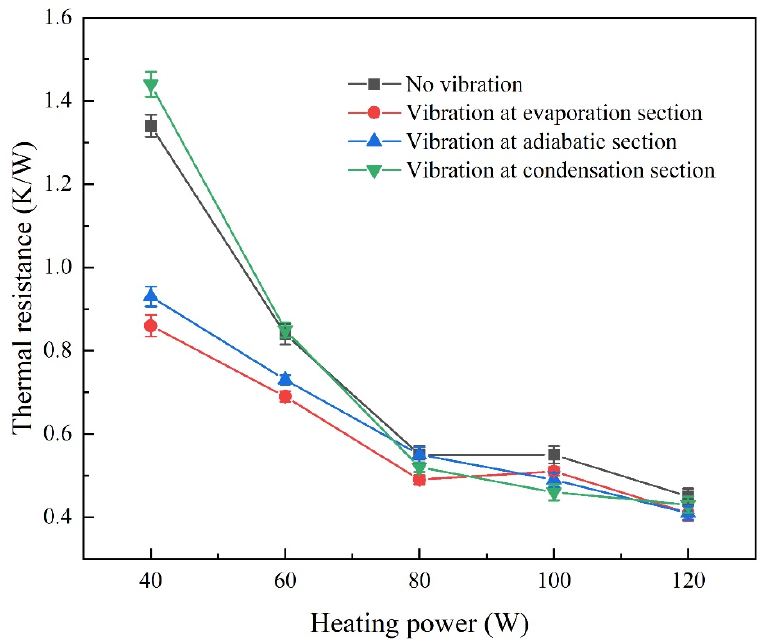
Figure 7. Influence of different vibration positions on the thermal resistance of the PHP under different heating power levels.